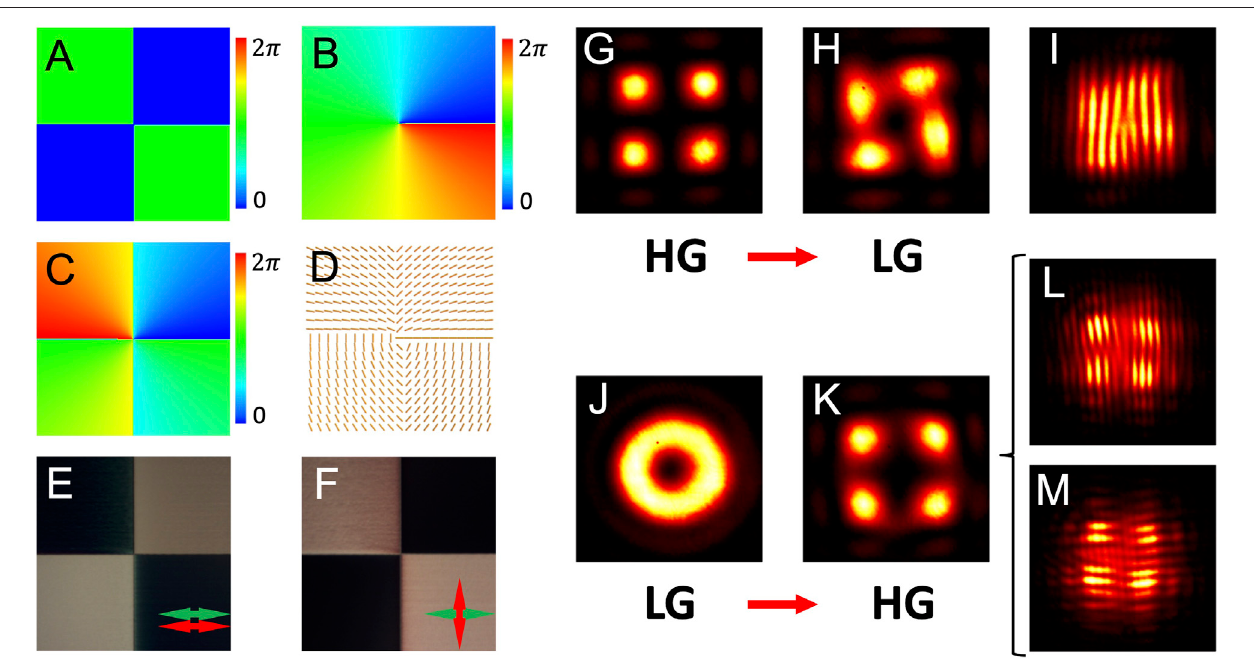
FIGURE 3 | (A – C) Phase pro fi les of the HG 11 mode, LG 01 mode, and integrated phase. (D) Distribution of local optical axes of the desired mode converter. (E,F) Polariscopic analysis results of the constructed device. Red and green arrows indicate the orientations of the incident polarization state and the orientation of